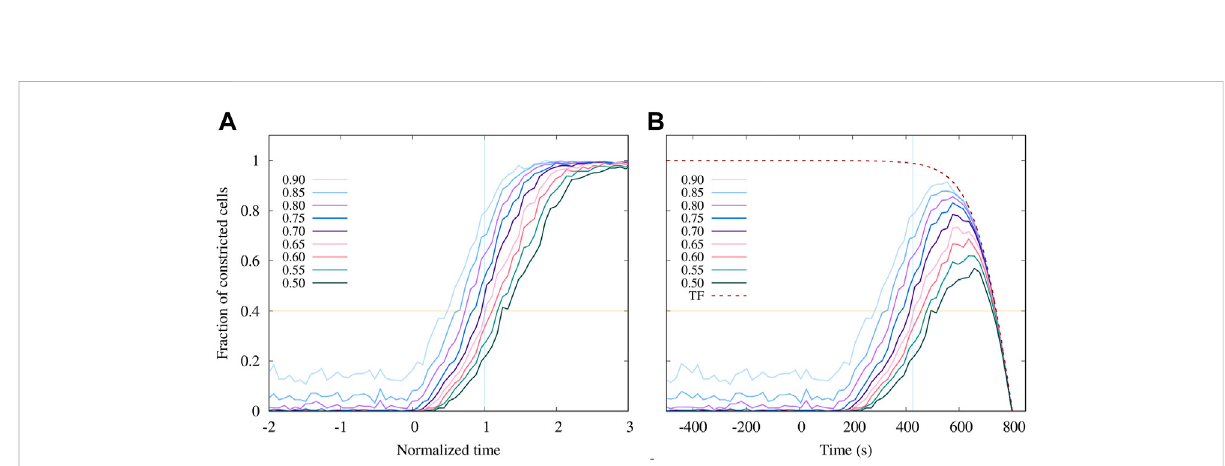
FIGURE 8 Predictions of the enhanced AGF model for the progression of the apical constriction process. (A) The fraction of active cells with the area reduction factor r A smaller than the speci fi ed value (as labeled) vs. normalized time (as de fi ned in Figure 6). (B) The results shown in (A) multiplied by the truncation function (TF) Eq. 15 that was fi tted to the fraction of tracked cells shown in Figure 3A (Embryo 1). The simulation time is shifted and rescaled to match the experimental timescale. The onset of the constrictions in the simulations is set to t = 150